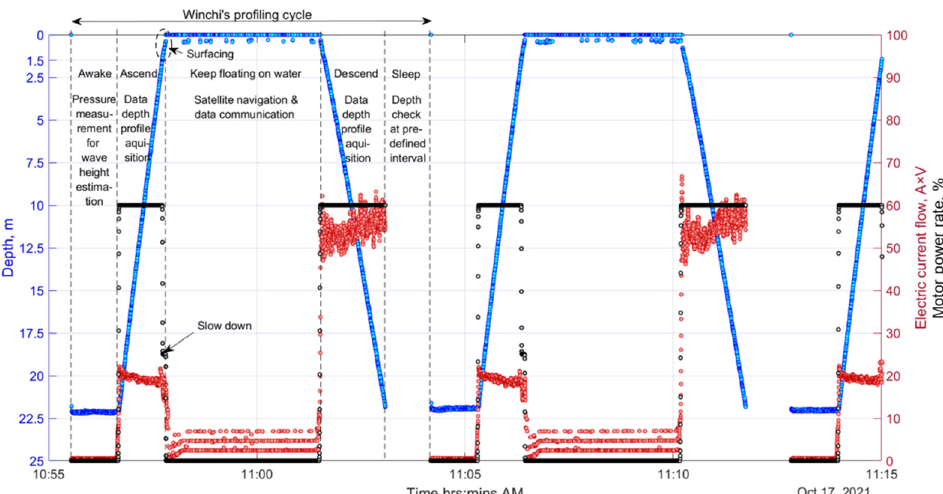
Figure 10. Typical profiling track (profiler depth versus time) and energy consumption under the conditions of a weak sea current less than 0.3 m/s. Blue circles indicate the depth of the profiler during deployment. Energy consumption is denoted by red dots. The black circles indicate regimes of the winch motor operation, i.e., the motor power rates are 60% when the profiler ascends and descends, 25% when the ascend speed slows down in the sea surface layer, and 0% when the profiler is on the sea surface. The microelectronic control unit of the system is switched to sleep mode when it is parked on the near-bottom layer.